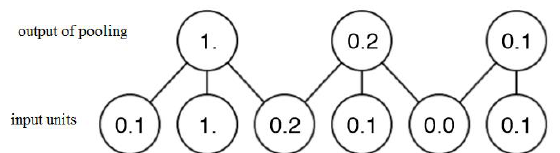
Figure 1: max pooling operation on the input units (Goodfellow et al,